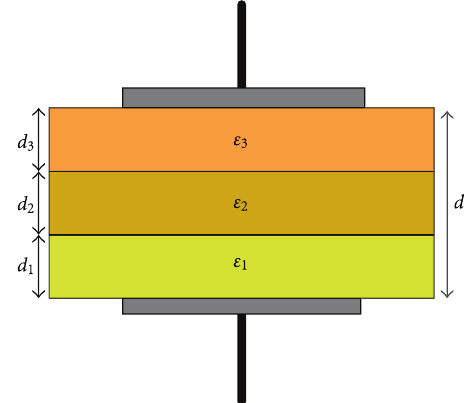
measured with/without slab interposition for radiated power of %